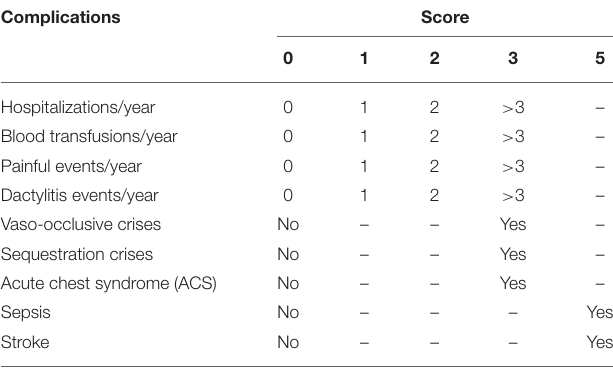
TABLE 1 | Scoring system for clinical evaluation of children with sickle cell